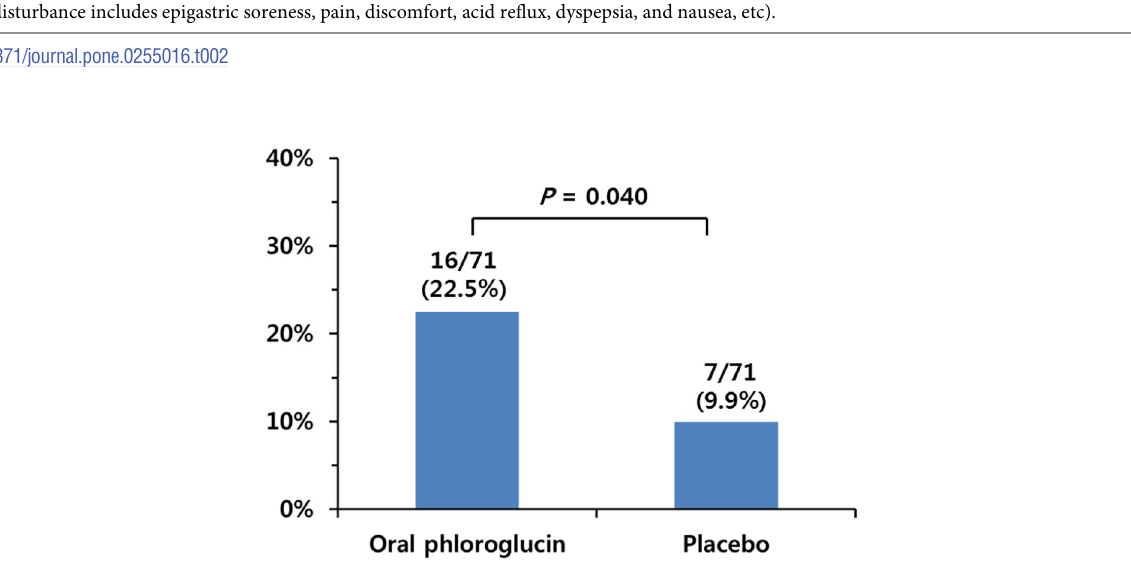
Fig 3. The proportions of subjects with complete suppression (Grade 1) of gastric